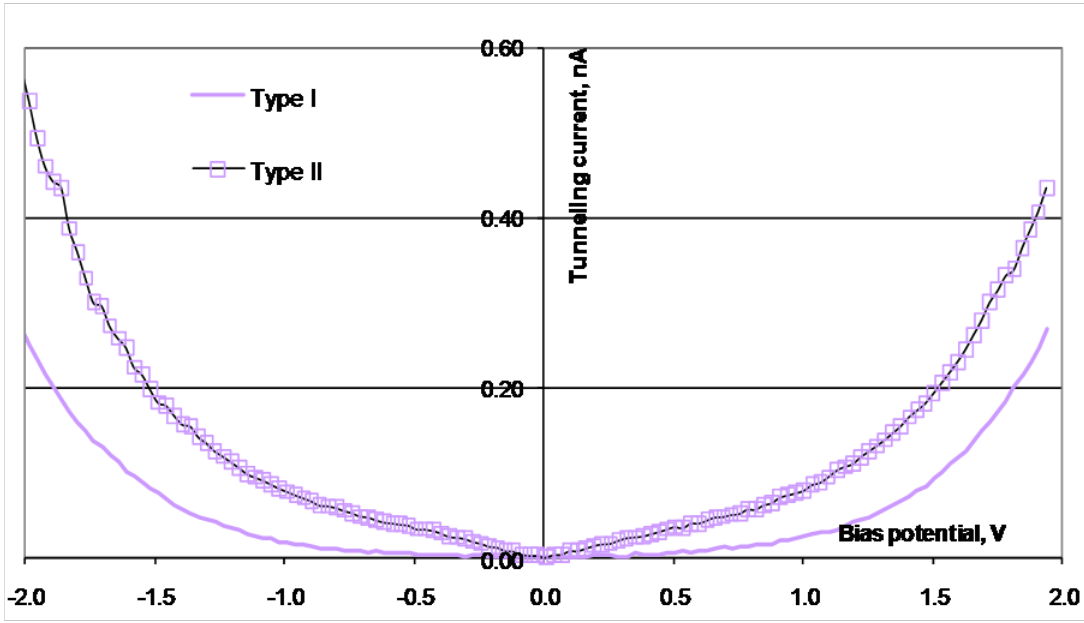
Figure 7. I(U) curves obtained from STS scans performed on the surface of Ni The absolute value of the tunneling current is used.